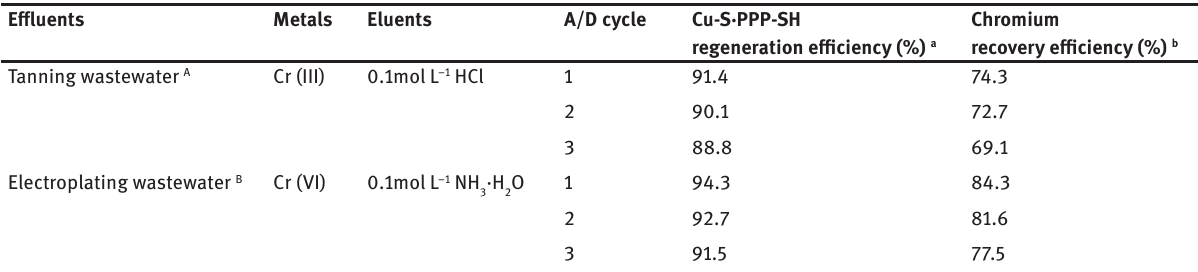
Table 3: Influence of starting effluents and eluents employed during repeated adsorption/desoprtion (A/D) cycles on the regeneration efficiency and chromium recovery